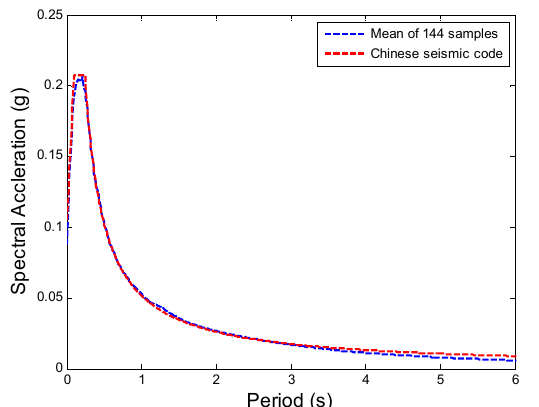
Figure 2. Comparison of the average response spectrum of 144 stochastic ground motions and the target standard response spectrum in the Chinese seismic code.